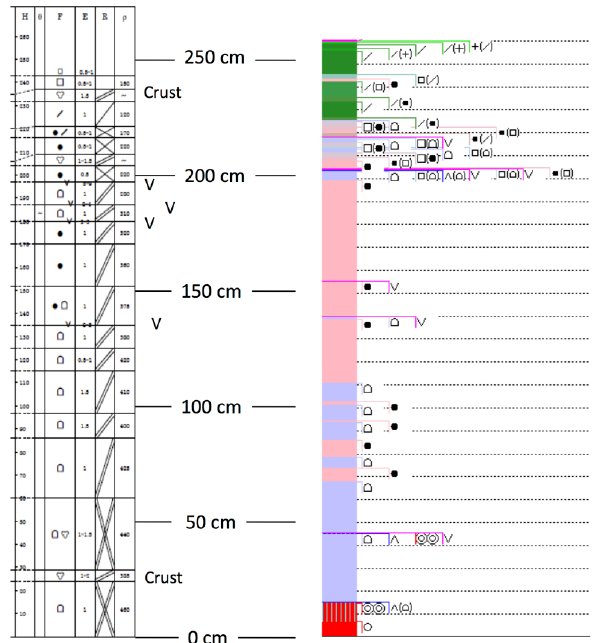
Fig. 5. Comparison of observed (left) and simulated profile (right) Figure 5: Comparison of observed (left) and simulated profile (right) for 20 March 89 for 20 March 2010 at Mt. Fidelity. Replaces former Fig. 2010 at Mt. Fidelity. Replaces former Figure 8. 90